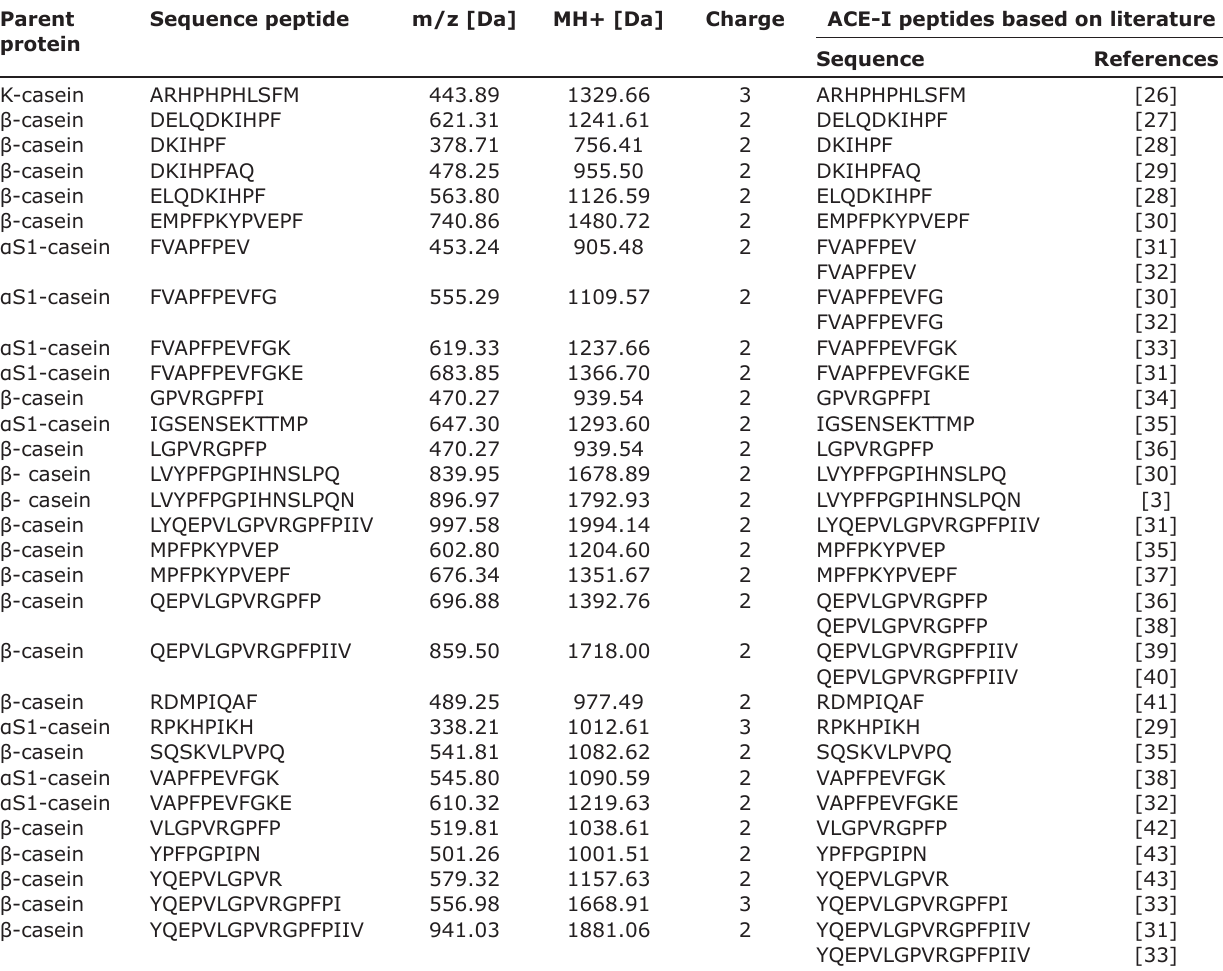
Table-6: ACE-I peptides produced in fermented milk using Lactobacillus kefiri YK4 and JK17 as starter culture compared to ACE-I peptides as reported in the literature. Parent